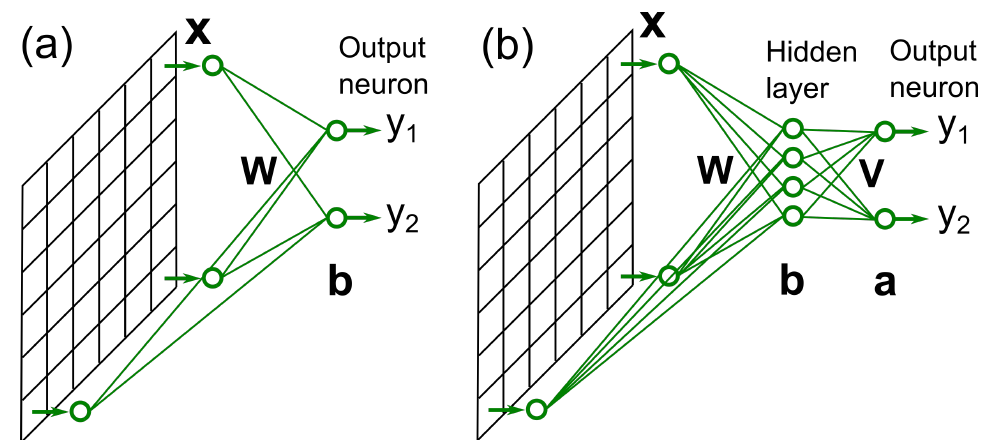
( ω ) as the inputs x give normalized outputs y Figure 1: ANNs with the LDOS N r and y as the ANNs’ probabilistic judgment and confidence on the input image being 2 symmetric or nematic, respectively. Each neuron processes its inputs x (cid:48) and outputs as y (cid:48) = σ ( W · x (cid:48) + b ) , where W are the weights associated with each of the inputs, b is a bias, and σ is a sigmoid function. (a) An ANN with no hidden layer, and (b) an ANN with one hidden layer are examples of the fully-connected feed-forward